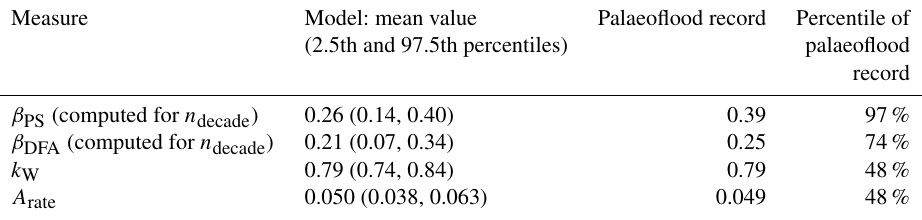
Table 2. Statistics of long-range persistence, clustering, and cyclicity properties of the specified ( β model = 0.24, A model = 0.30) palaeoflood model; 1000 model realizations were created and their long-range correlations ( β PS and β DFA ), clustering ( k W ), and cyclicity properties ( A rate ) were quantified. Given is for each measure the mean value and the 2.5th and 97.5th percentiles of the model realizations, the value measured for the palaeoflood record, and the percentile of the value measured with respect to the values of the